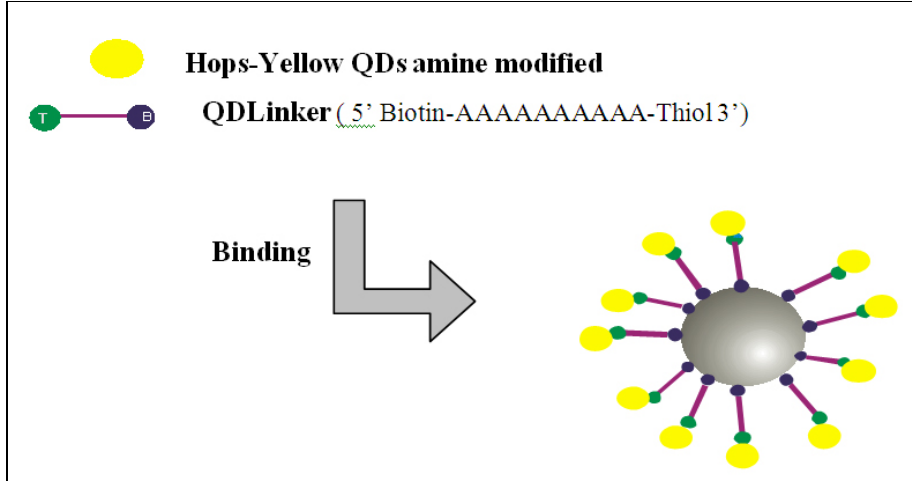
Figure 2. Schematic representation of QDLinker (a thiol-modified probe) coupled to amine-modified Hops-Yellow QDs by covalent interactions followed by the binding to Dynabeads by the biotin-streptavidin